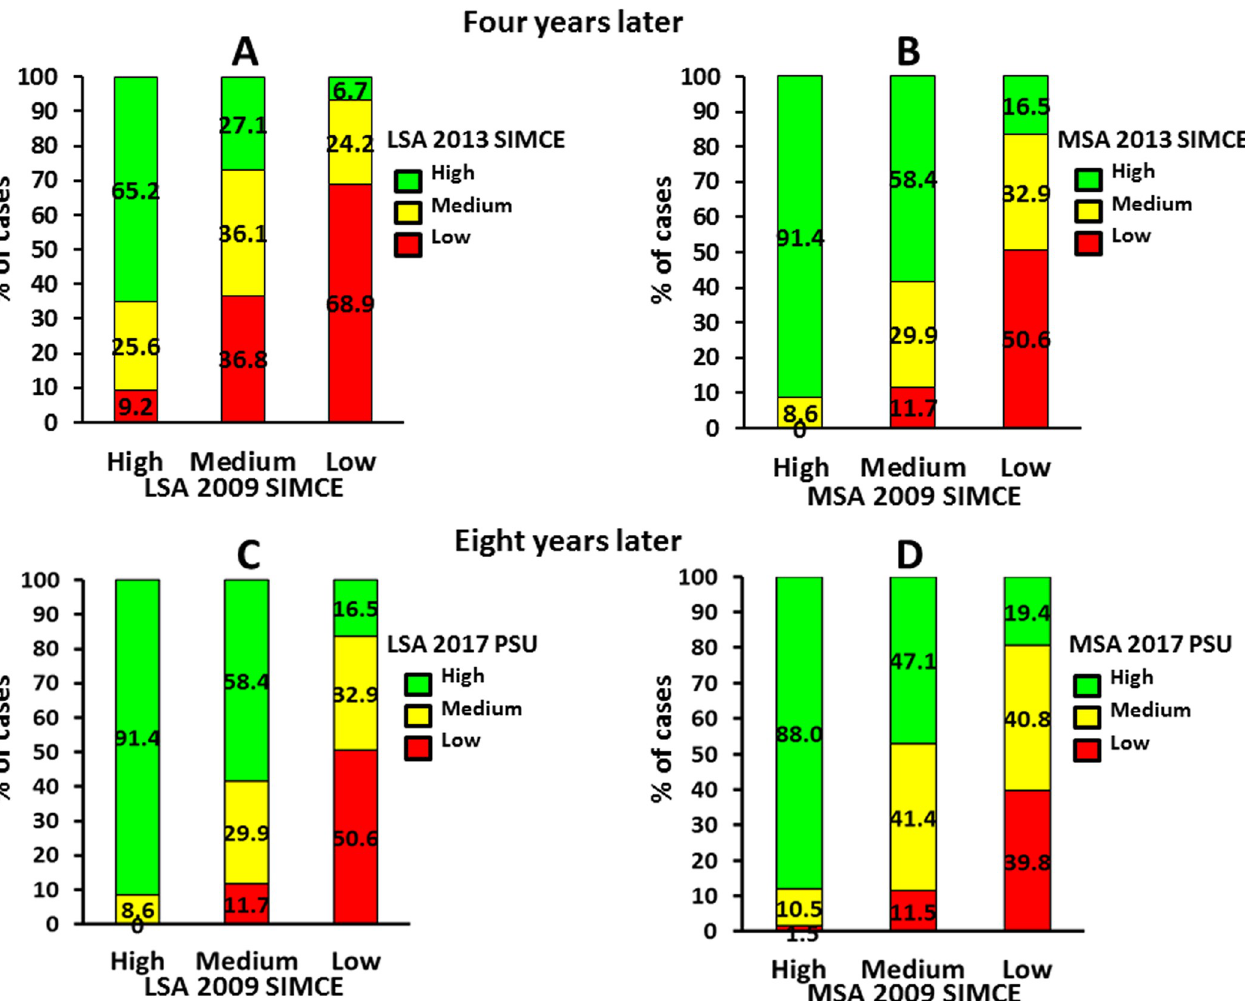
Fig 5. Association between the 2009 Quality Education Measurement System (2009 SIMCE) test of school-age children of the 2010 5ESG, four years later, with the 2013 SIMCE test, when they graduated from 8 th grade of elementary school, both language (LSA) (A) and mathematics (MSA) (B) and, eight years later, with the 2017 University Selection Test (2017 PSU) outcomes, for university admission, when they graduated from high school, both LSA (C) and MSA (D). Note. A. ( X 2 (4df) = 167.580 > X 2 (4df) p < .001 = 18.465). B. ( X 2 (4df) = 219.503 > X 2 (4df) p < .001 = 18.465). C. ( X 2 (4df) = o t o t o 116.899 > X 2 t (4df) p < .001 = 18.465). D. ( X 2 o (4df) = 95.113 > X 2 t (4df) p < .001 =